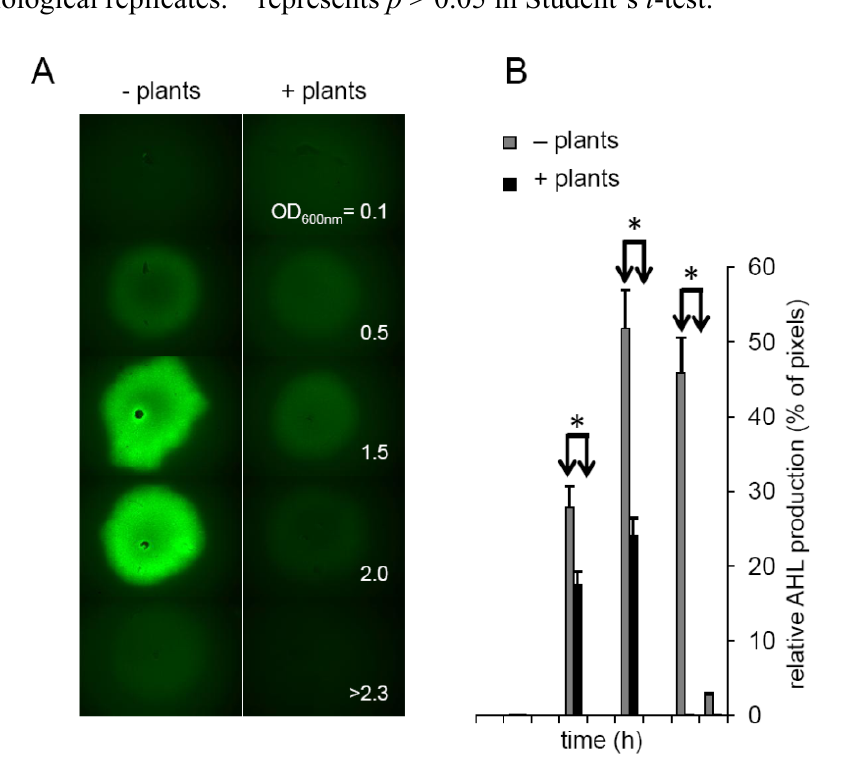
Figure 3. The presence of plants has a negative impact on the accumulation of AHLs produced by S. meliloti. ( A ) Accumulation of AHL produced by S. meliloti expR + in culture with and without Arabidopsis plants was monitored using the bacterial biosensor strain P. putida KS35; ( B ) Quantification of the AHL production using a segmentation algorithm. Five photographs were taken per time point (see ( A )) and tested for the ratio of GFP-positive pixels. The experiment was repeated five times. Error bars represent the S.D. between biological replicates. * represents p > 0.05 in Student’s t